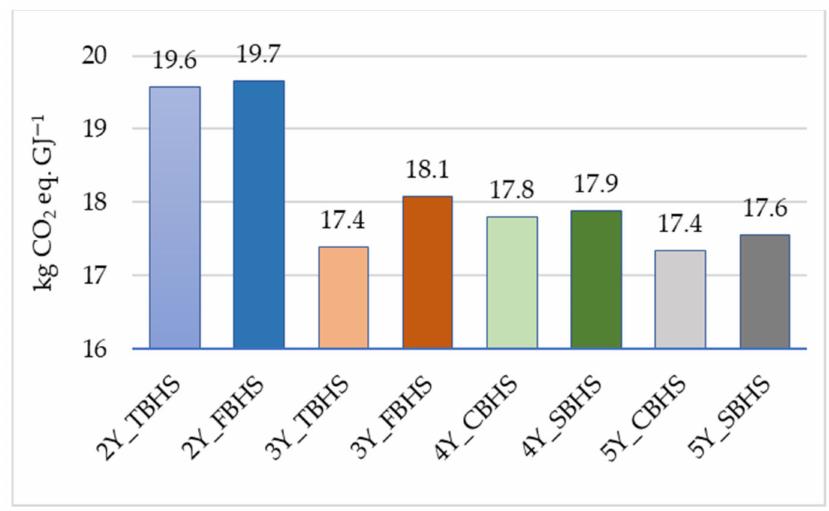
Figure 3. Emissions per GJ of thermal energy produced (in kg CO 2 eq) with reference to the TBHS, FBHS, CBHS and SBHS harvesting systems (IPCC GWP